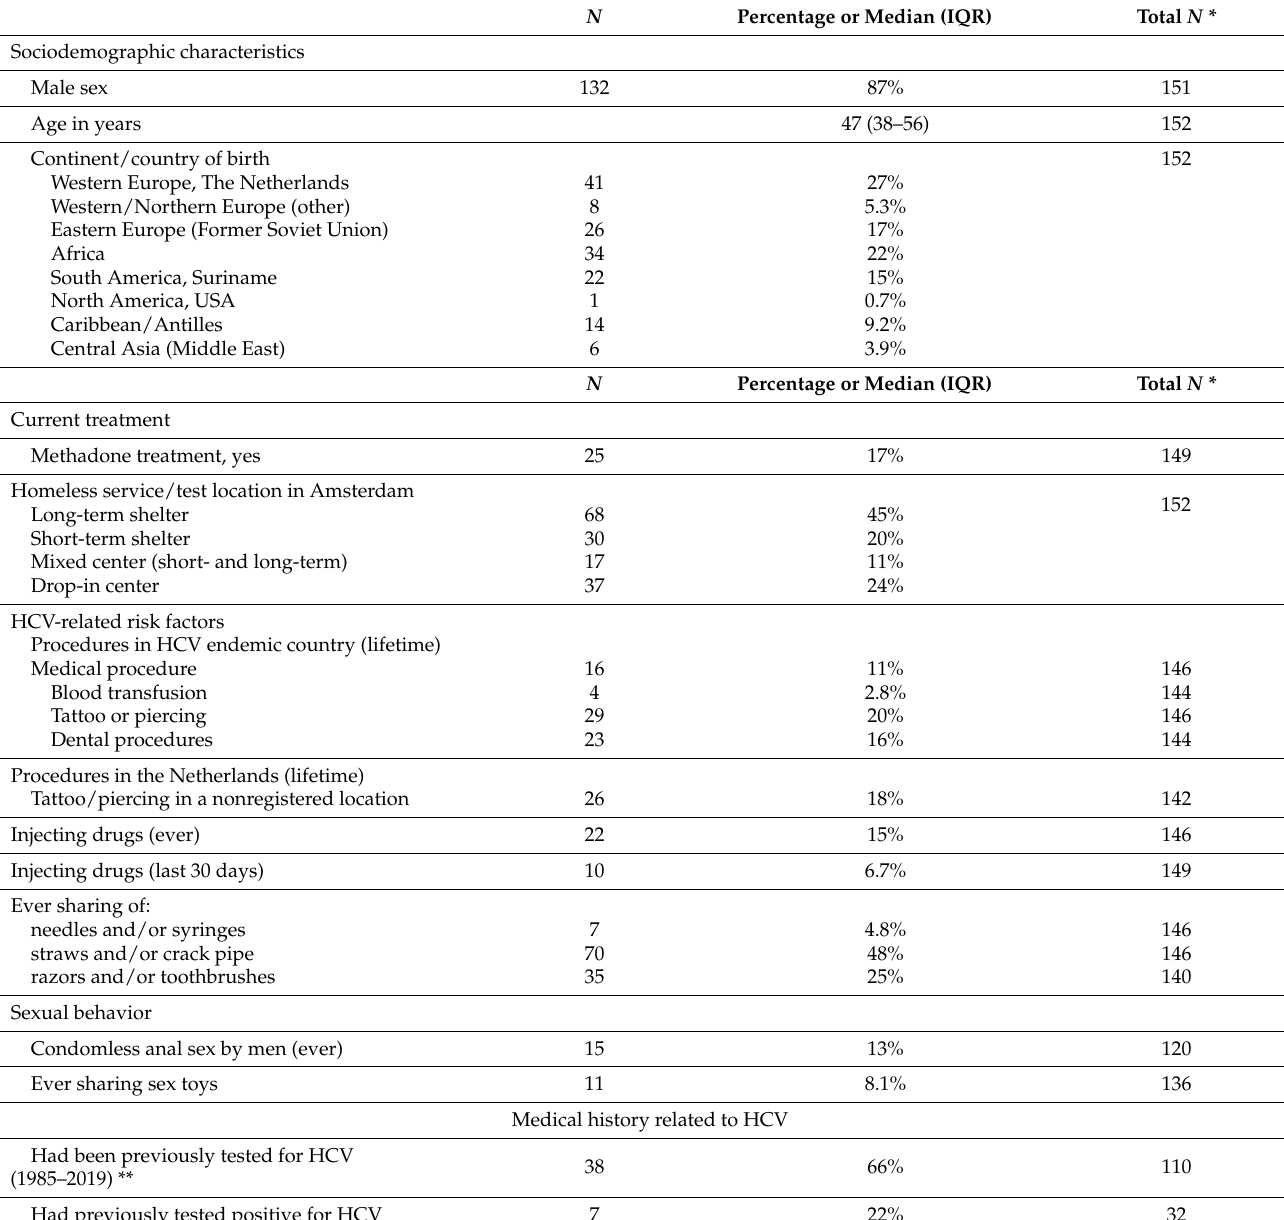
(3/7) reported recent injecting drug use. These proportions were higher than those of the overall study population (ever: 15%, 22/146; recent: 6.7%, 10/149). Five people were unaware of their HCV status (Table 1) and two people previously tested positive for HCV. One person declared that he had tested HCV positive in the past, but was never treated (for unknown reasons). The other person declared that he was not treated in 2010 because of injecting drug use. The medical specialist of the hospital likely advised against treatment with interferon at that time. Two people unaware of their HCV status reported recent and prior injecting drug use. Two people reported no recent or prior injecting drug use, and one person did not answer this question during the interview. Table 1. Characteristics of the study population of eight homeless services in Amsterdam, the Netherlands, in January– March 2020 ( N = 152). N Percentage or Median